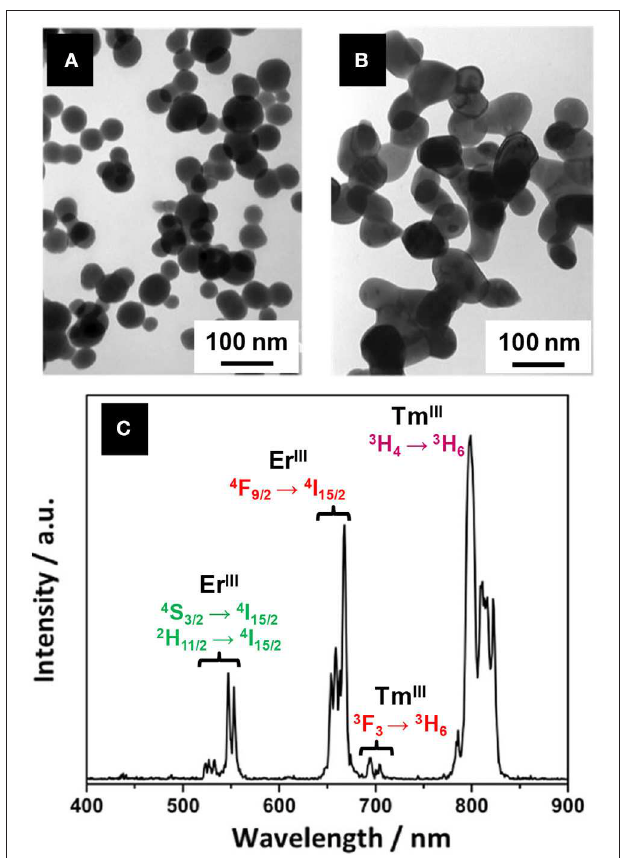
FIGURE 11 | TEM micrographs of Y 2 O 3 :Er (A) and Y 2 O 2 S:Er@Y 2 O 2 S:Yb,Tm nanoparticles (B) synthesized by Tian et al. (C) Luminescence spectrum of Y 2 O 2 S:Er@Y 2 O 2 S:Yb, Tm nanoparticles under 1,550nm excitation that exhibits the multicolor fluorescence of the core-shell nanoparticles (in the near-infrared region, between 780 and 830nm, the 4 I 9 / 2 → 4 I 15 / 2 transition of Er III was proven to play a minor role). Adapted from Tian et al. (2017) with permission of